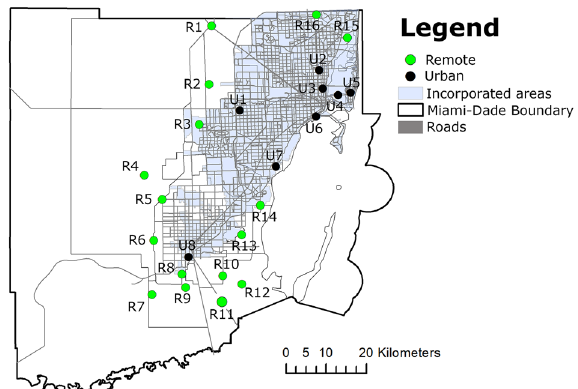
Figure 4. Map showing the location of the remote and urban collection sites in Miami-Dade, Florida (latitude, 25.761681; longitude, -80.191788). The figure was produced using ArcGIS 10.2 (Esri, Redlands, CA) using freely available layers from the Miami-Dade County’s Open Data Hub— https:// gis- mdc. opend ata. arcgis. com/.